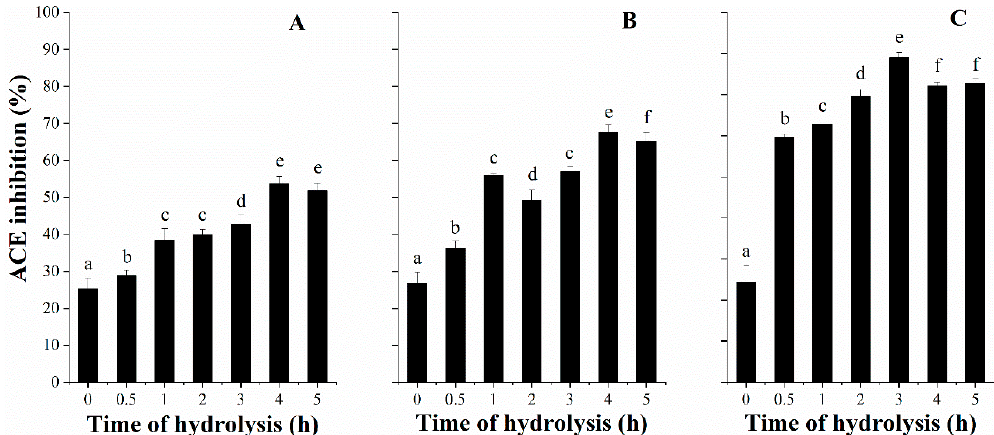
Figure 2. Angiotensin converting enzyme (ACE) inhibitory activity of DDSG-PI hydrolysates as a function of hydrolysis time using different proteases. Key: ( A ), Flavourzyme; ( B ), Neutrase; ( C ), Alcalase. Hydrolysates were taken at 0, 0.5, 1, 2, 3, 4, and 5 h, freeze-dried, and then ACE inhibitory activity was measured at a final concentration of 1 mg/mL (based on dry weight (DW)). All data were presented as means ± SD ( n = 3). Samples with different letters in the same sample group showed significant differences (p < 0.05).